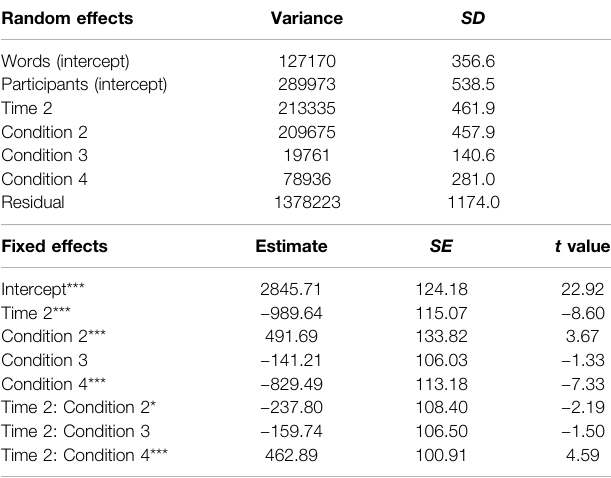
TABLE 13 | All the contrasts of the response times of correct answers of Chinese word and picture pairs (CP), Chinese word and Japanese word pairs (CJ), Chinese words only (C), and novel Chinese words (CN) in learning condition retrieval